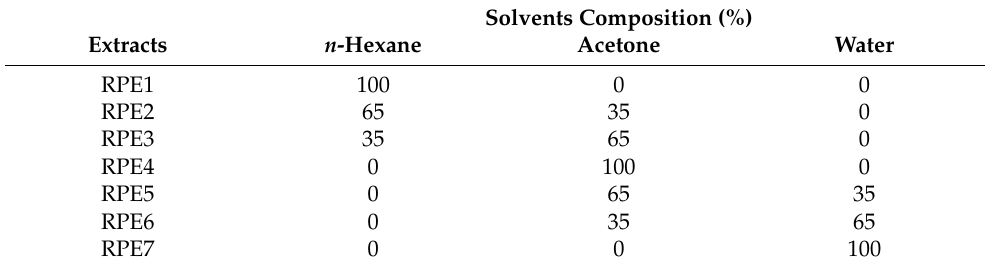
Table 1. Solvent composition used for the speed